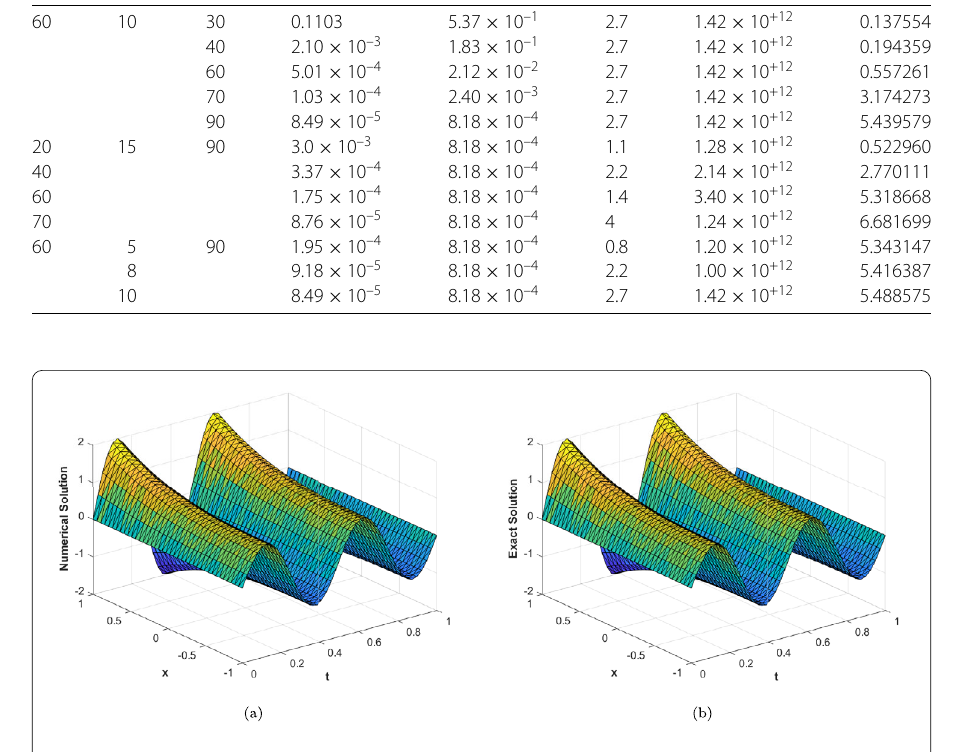
Figure 6 ( a ) Numerical solution. ( b ) Exact solution